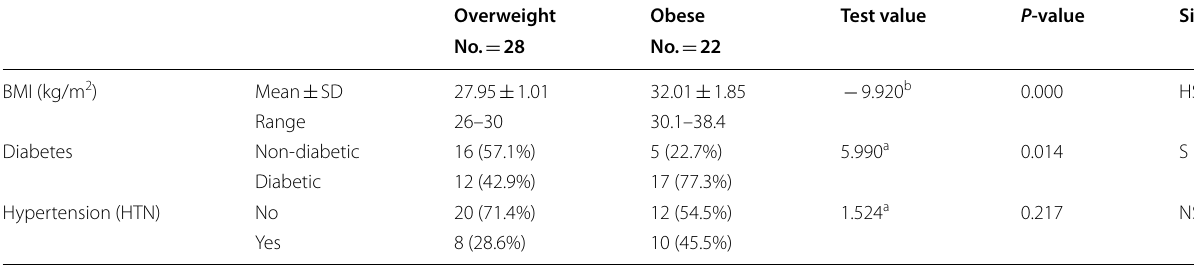
P -value > 0.05, non-significant; P -value < 0.05, significant; P -value < 0.01, highly significant a